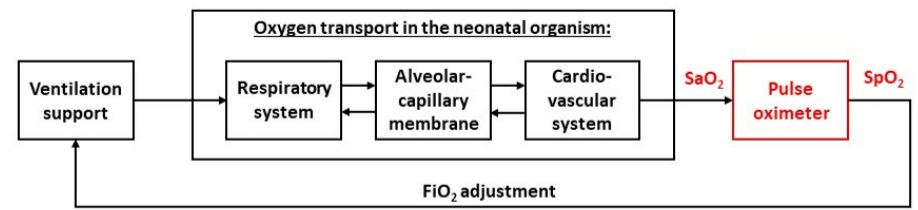
Figure 1. A general concept of the mathematical model of neonatal oxygen transport. The pulse oximeter module, with arterial oxygen saturation (SaO 2 ) as the input and peripheral oxygen satura- tion (SpO 2 ) as the output, is the terminal part of the global model.